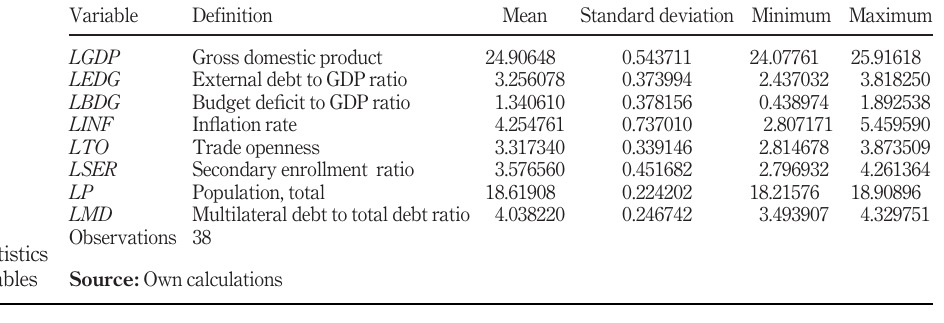
Variable Normalized weights LINF Table 4. Weights of each variable Source: Own